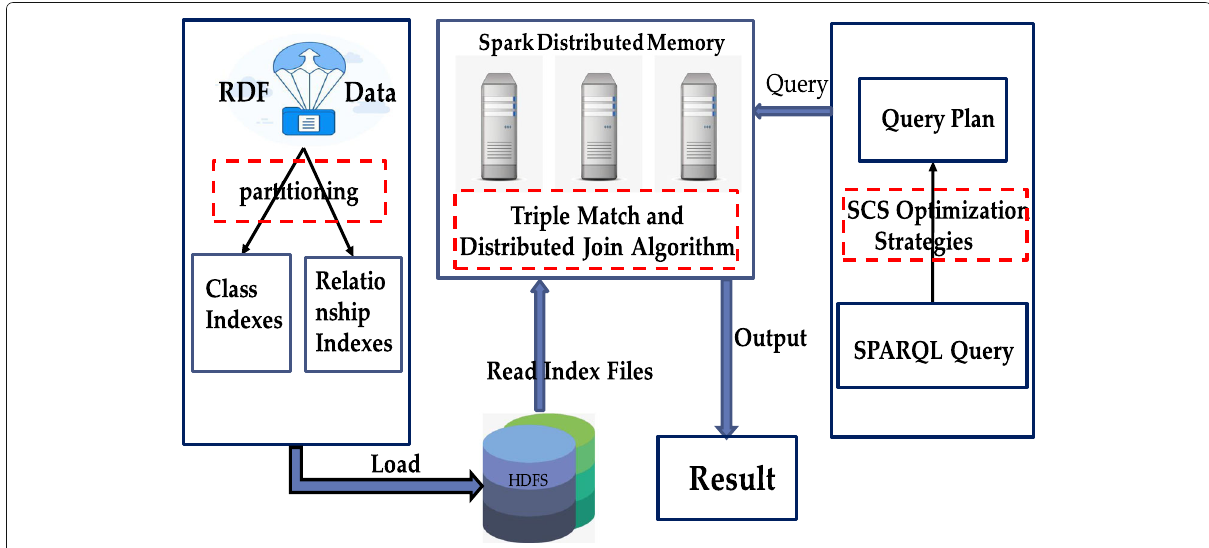
Fig. 4 System architecture